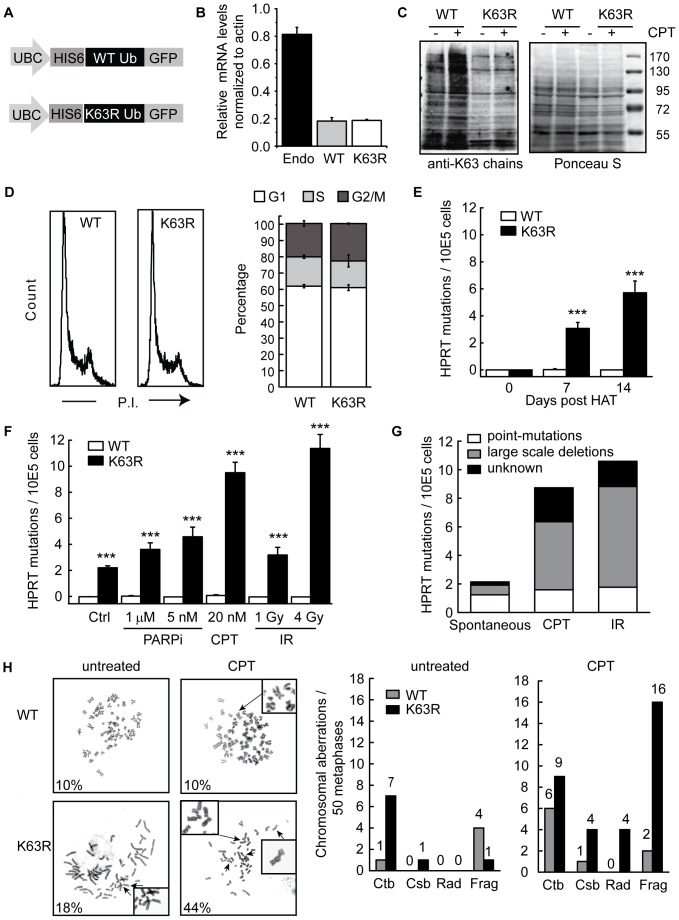
K63RUb expression induces genomic instability.(A) Schematic overview of WTUb and K63RUb expression constructs. Expression of a 6xHis-tagged WT or K63R ubiquitin B-GFP fusion protein is driven by the UBC promoter. (B) mRNA expression levels of endogenous ubiquitin B and expressed 6xHis-tagged WT or K63R ubiquitin B determined by real-time PCR. (C) Impaired K63-linked ubiquitin chain formation, in untreated or CPT (1h, 100nM) treated A549 K63RUb cells, confirmed by comparison to K63 ubiquitin chain abundance in A549 WTUb cells by Western blot using a K63-chain specific antibody. Ponceau S staining indicates equal loading. (D) Cell cycle distribution of normal cycling A549 WTUb and K63RUb overexpressing cells determined by FACS analysis. Data are mean of 3 independent exp's ± sd. (E-F) Mutations at the HPRT locus analysed in WTUb and K63RUb HPRT mutant-free HAT-selected cells after (E) 0, 7 or 14 days proliferation (spontaneous), data are mean ± s.e.m. of 7 (7 days growth) and 2 (14 days growth) independent exp's (n =  5-50 per exp). (F) 6 days continuous treatment with 1 µM PARPi, 5 or 20 nM CPT, 1 and 4 Gy IR, Ctrl is 7 days spontaneous. Data are mean ± s.e.m. of 3 independent exps (n = 5 per exp). (G) A549 K63RUb cells were treated as described in (e) to obtain spontaneous, CPT- and IR-induced HPRT mutated clones. RNA and genomic DNA were isolated from individual colonies and mutations were assessed by sequence analysis of HPRT cDNA and/or exon1-9 presence was scored by exon-specific PCR amplification. (H) Metaphases of untreated or CPT-treated (20 nM, 24 h) WTUb and K63RUb cells were harvested. Chromosomal aberrations were scored using giemsa-staining in 50 metaphases per treatment. Data represents average ± s.e.m. *P<0.05, **P<0.01, ***P<0.001.